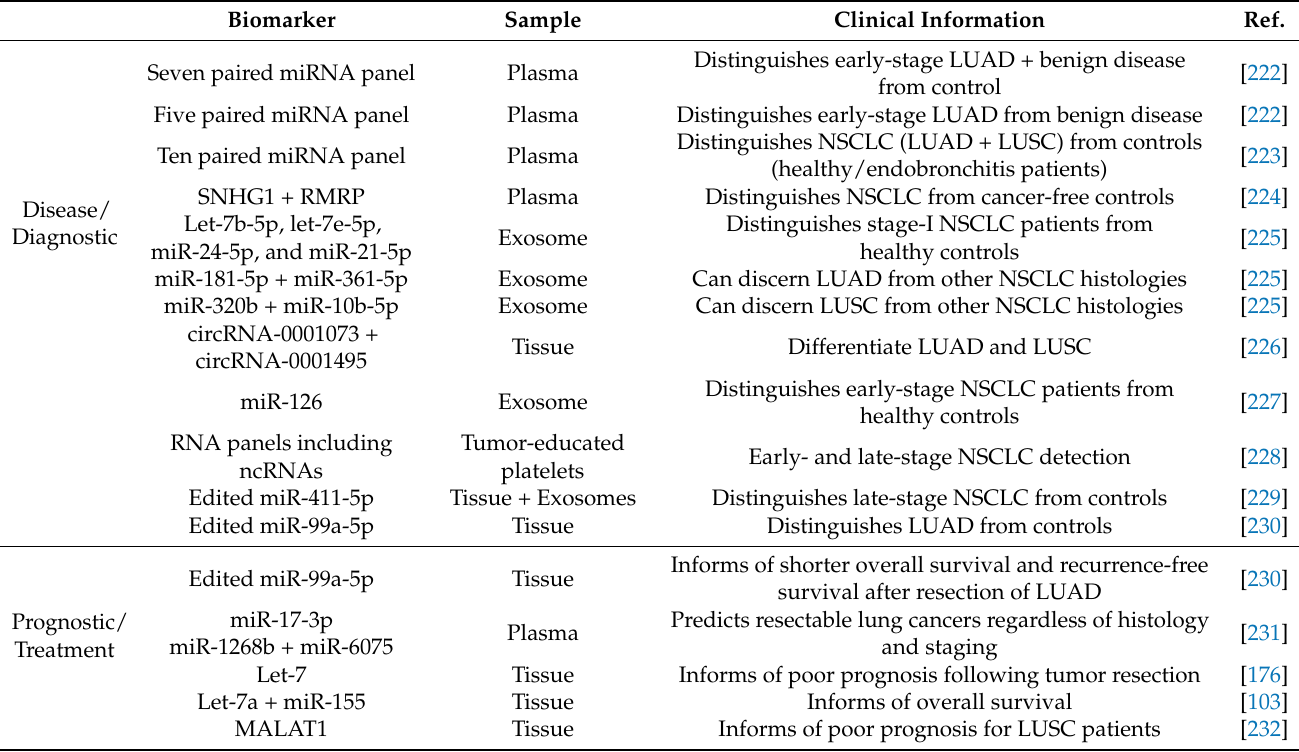
Table 2. ncRNA biomarkers in lung